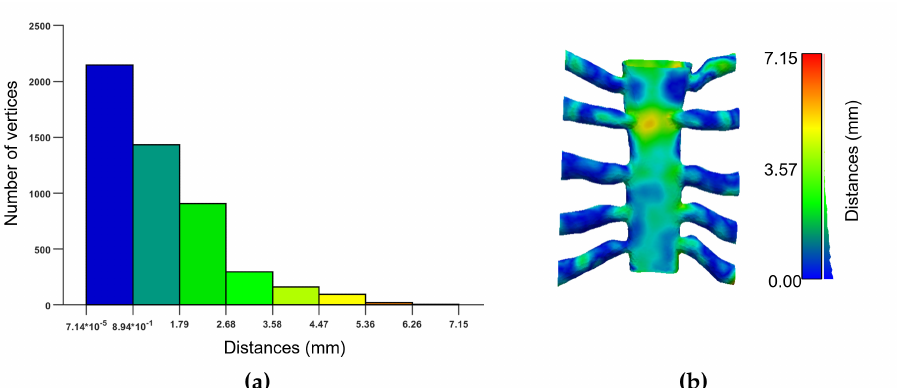
Figure 3. Bar plot of the E rec for a representative case. Only 121 vertices show a distance of more than 4.47 mm on a total of 5070 mesh points and of these, only 26 present a distance ranging between 5.36 and 7.15 mm ( a ). The spatial localisation of E rec to visualise which regions present the minimum and maximum differences between the two approaches for aRC reconstruction ( b